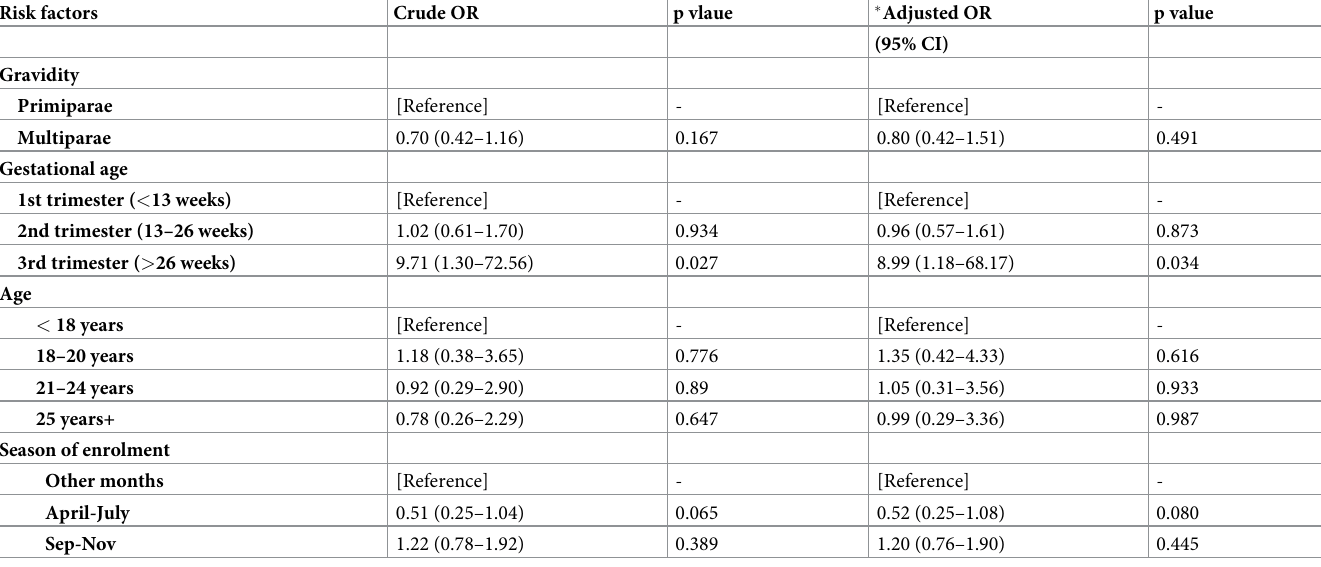
The relationships between P . falciparum , non- falciparum and mixed infection at enrolment and at delivery, and poor pregnancy outcomes such as prematurity, LBW and maternal Table 5. Risk factors for P . falciparum and non- falciparum malaria mixed infections at